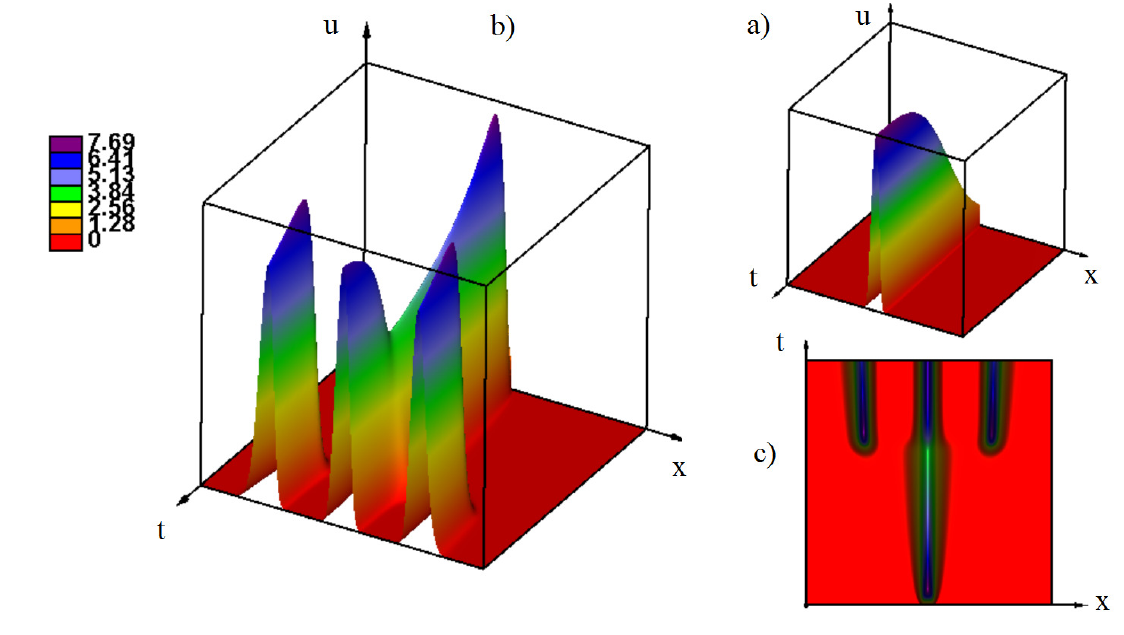
Figure 6. Emergence of a periodic wave in numerical simulations of Equation (1). ( a ) At the first stage, solution growth remaining localized at the center of the interval. ( b ) Then it decreases and widens, and after some time, other peaks of solution appear. ( c ) Another representation of the same solution as in ( b ). Values of parameters: D = 10 − 5 , r = 1, q = 1, N = 0.2, τ = 0, f ( u ) = 0, the maximum of the initial condition 0.9, t =